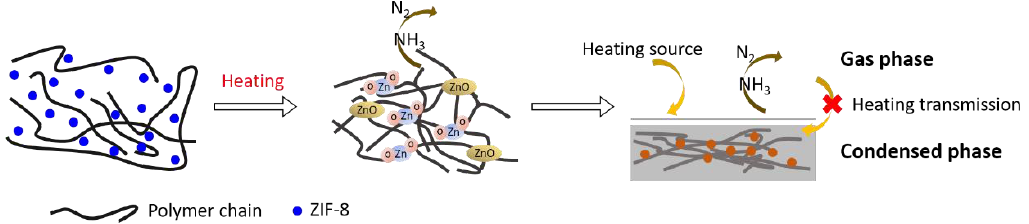
Figure 36. Flame-retardant process of nano-ZIF-8 particles (NZPs). Reproduced with permission from Ref. [239]. Copyright 2017, American Chemical Society.